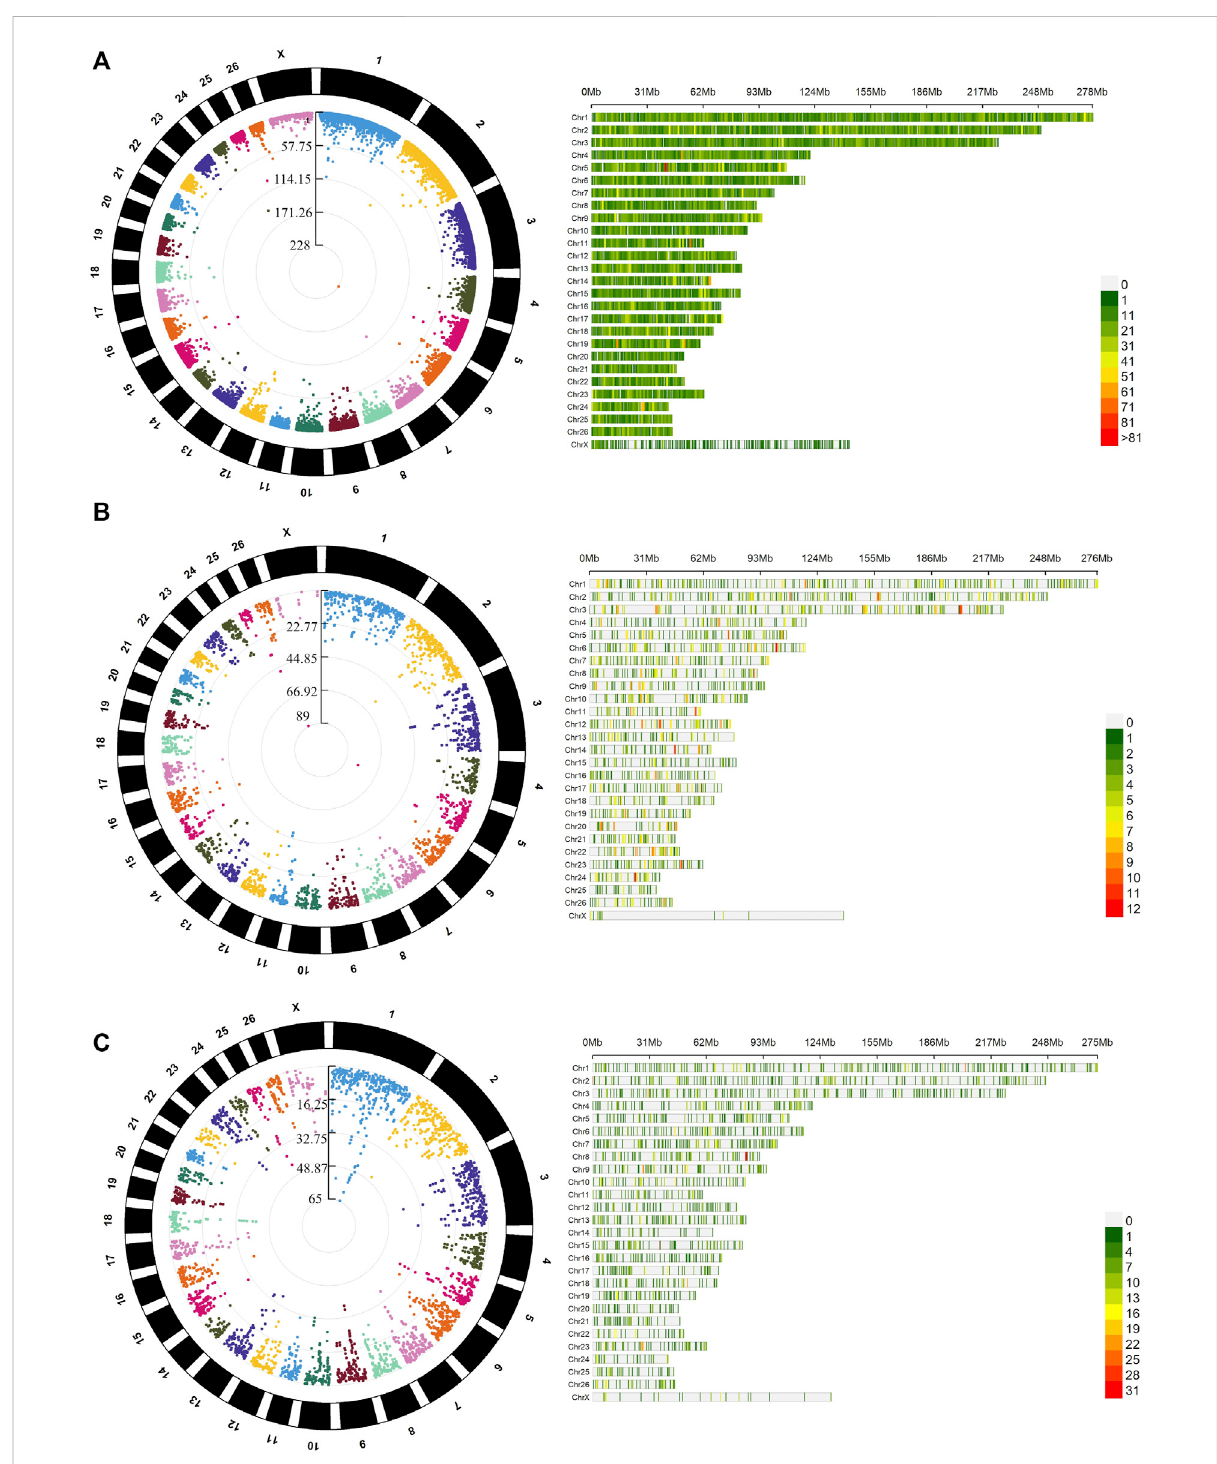
FIGURE 2 Distribution and genomic density of differentially methylated loci (DMLs) across the genome of Assaf lambs in the three evaluated methylation contexts CG (A) , CHG (B) , and CHH (C) . On the right-hand side, the circular Manhattan plots show the distribution of – DMLs in the comparison between males and females (log 10 ( p -values) after false discovery rate adjustment for the detected). On the left-hand side, the bar plots show the density of DMLs within 1 Mb windows for each sheep chromosome. A darker red shade indicates a higher number of DMLs within the 1 Mb